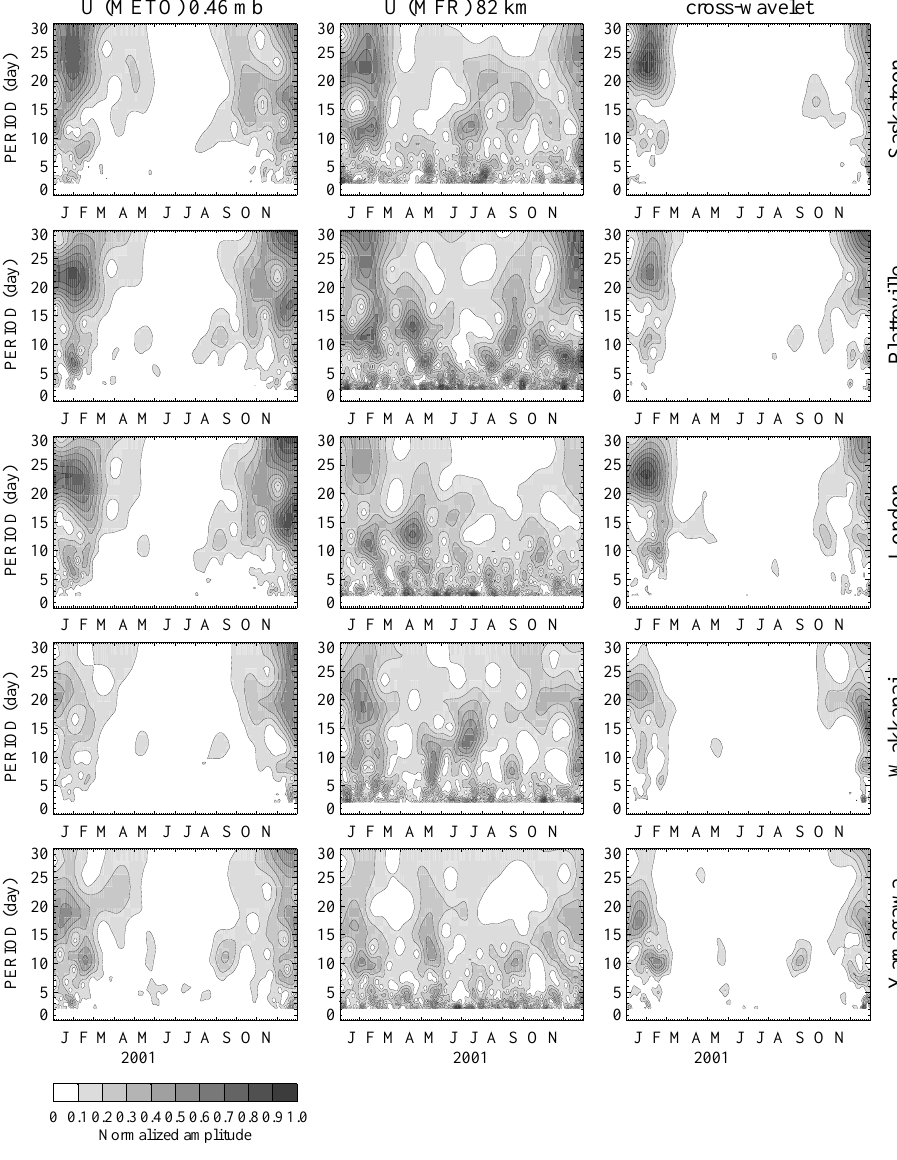
Fig. 6. ( b ) The same as Fig. 6a, but for the zonal (U)